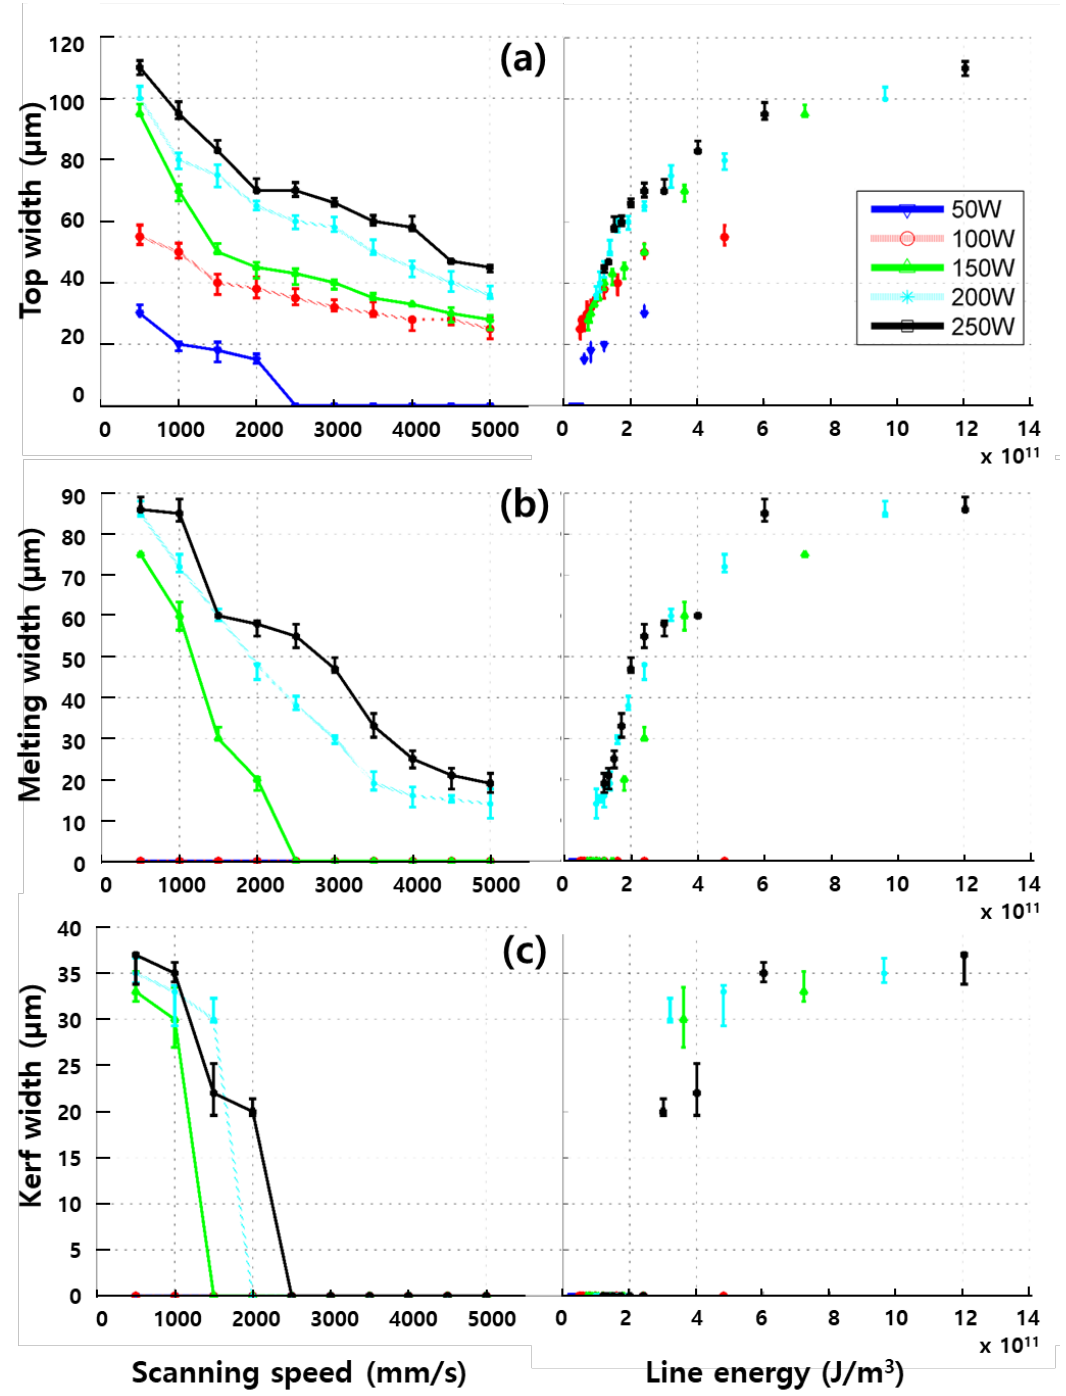
Figure 4. Comparison of ( a ) Top width; ( b ) Melting width; ( c ) Kerf width.